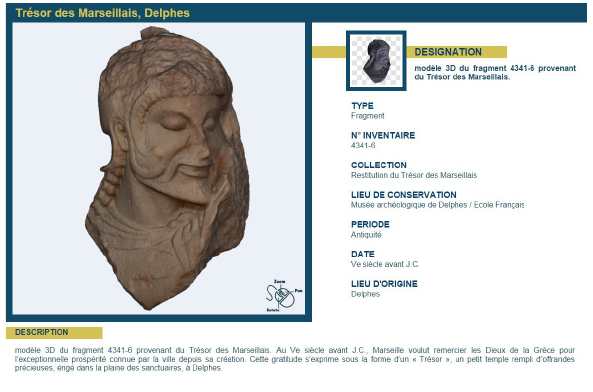
Figure 9: Screen capture of our web